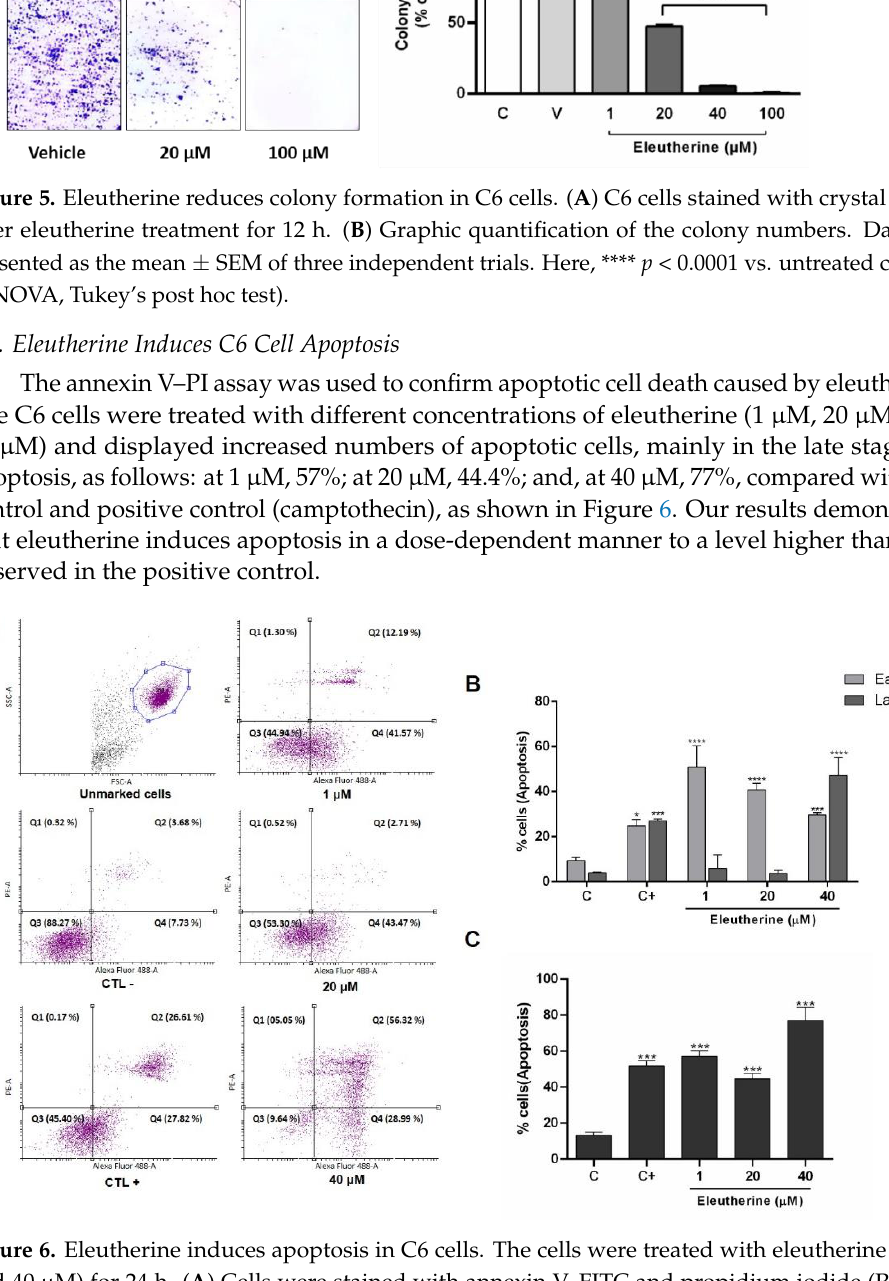
Figure 7. Eleutherine treatment reduced AKT phosphorylation in C6 cells. The expression of pAKT and AKT, and of GAPDH as the control protein, was detected by western blotting. The pAKT:AKT ratio is expressed as a percentage. The eleutherine treatment groups (20 and 40 µM) showed a